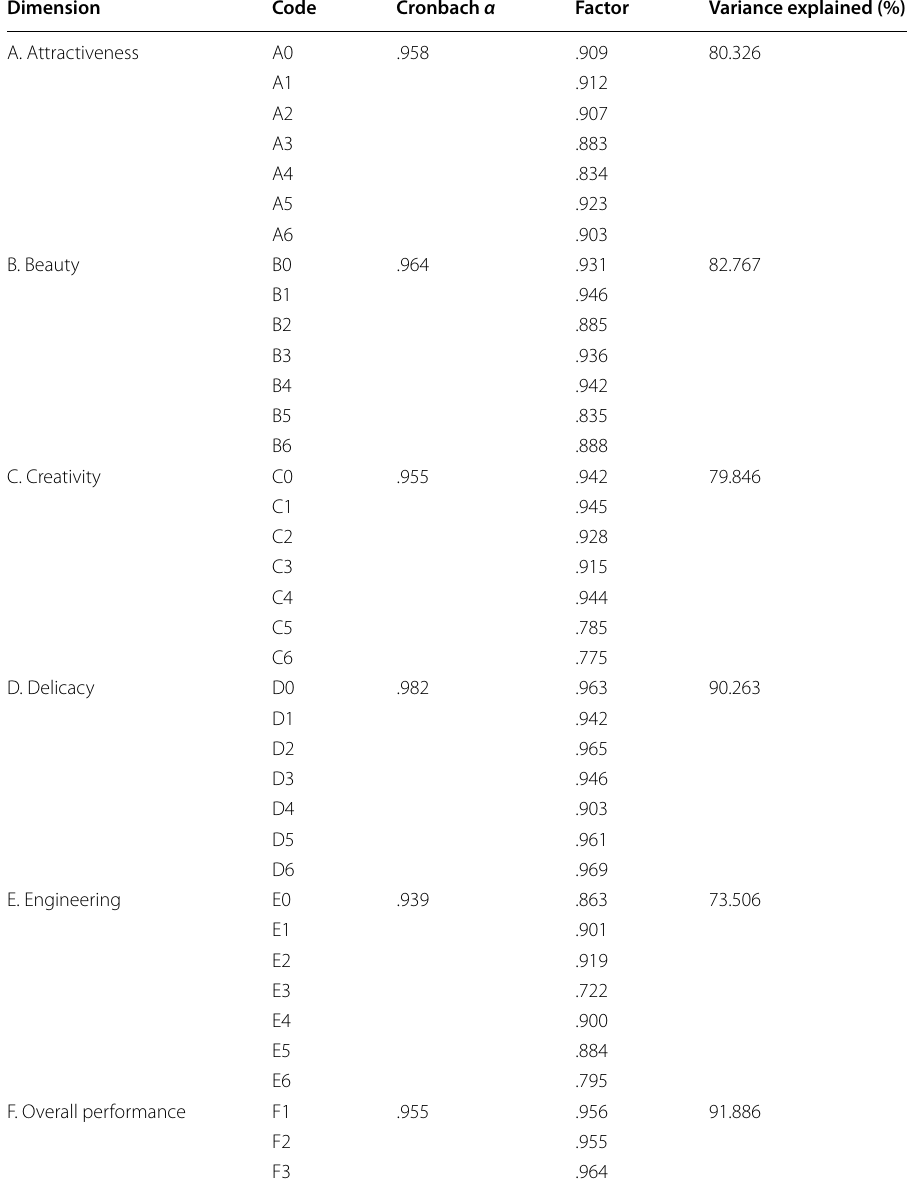
Table 3 The reliability and validity of questionnaire (N